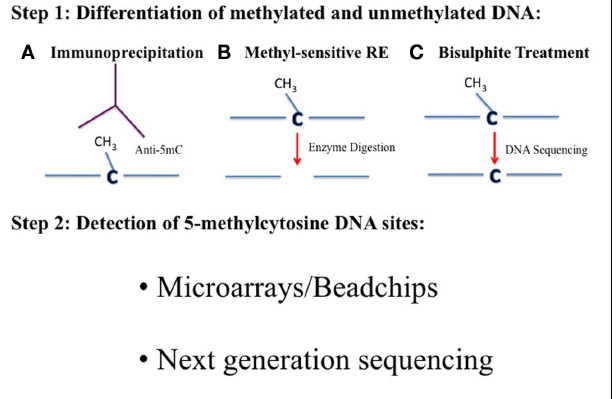
FIGURE 2 |The three main current approaches for DNA methylation analysis of genomes. The analyses of DNA methylation patterns across a genome at varying degrees of resolution involves three main approaches. In Step 1 methylated and unmethylated cytosines need to be distinguished. This can be achieved by using methods A, B, or C. (A) Immunoprecipitation with an antibody against 5mC (Anti-5mC)/methyl-binding protein or precipitation with specific methyl-binding proteins. (B) Digestion of DNA with methyl-sensitive restriction enzymes (RE) that cleave methylated and unmethylated cytosines differently. (C) Bisulfite treatment of DNA will convert unmethylated cytosines to uracil, which are “read” asTs when PCR amplified and sequenced. Methylated cytosines remain as cytosines when sequenced.The 5mC sites can then be identified in Step 2 by either using a microarray or beadchip platform or by next-generation